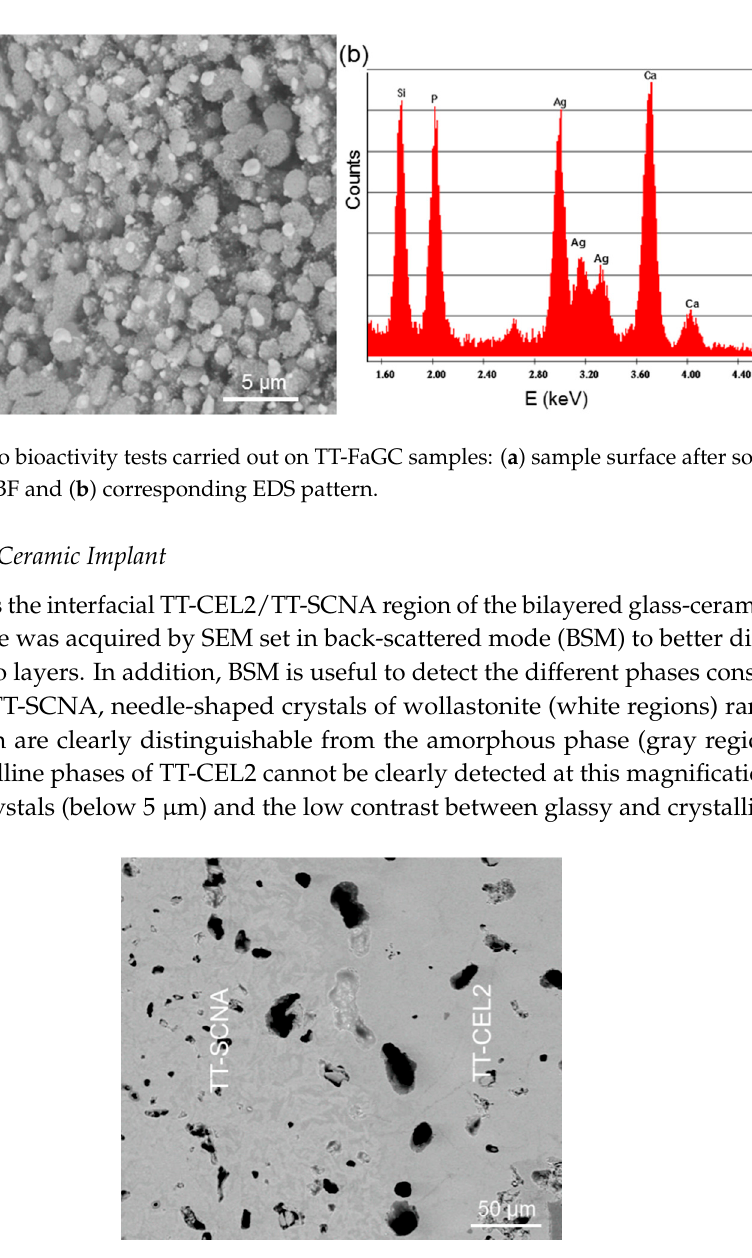
8 of 15 Figure 5. XRD pattern of TT-CEL2 after soaking for seven days in SBF. Figure 6a shows the surface of TT-FaGC after soaking for seven days in SBF; the corresponding EDS pattern is reported in Figure 6b. The sample surface is still coated by a silica-gel layer: its presence is revealed by the compositional analysis (an intense peak for Si is visible in Figure 6b) and its typical “clump-like” morphology is due to the condensation of Si-OH groups (stage 3 of the bioactivity mechanism [36,37]). Small globular agglomerates, rich in Ca and P, are visible on the top of the silica-rich layer: their presence demonstrates that the CaO–P 2 O 5 -rich film formed on the top of the gel layer begins to crystallize (stages 4 and 5 of the bioactive process [38]). It has to be noticed that the first stage of the bioactive process, i.e., the ion-exchange of cationic species from the glass and H + from the solution, is the rate-determining step for the whole mechanism of bioactivity. On the basis of this consideration, it is possible to give a qualitative explanation of the different bioactive behaviour of